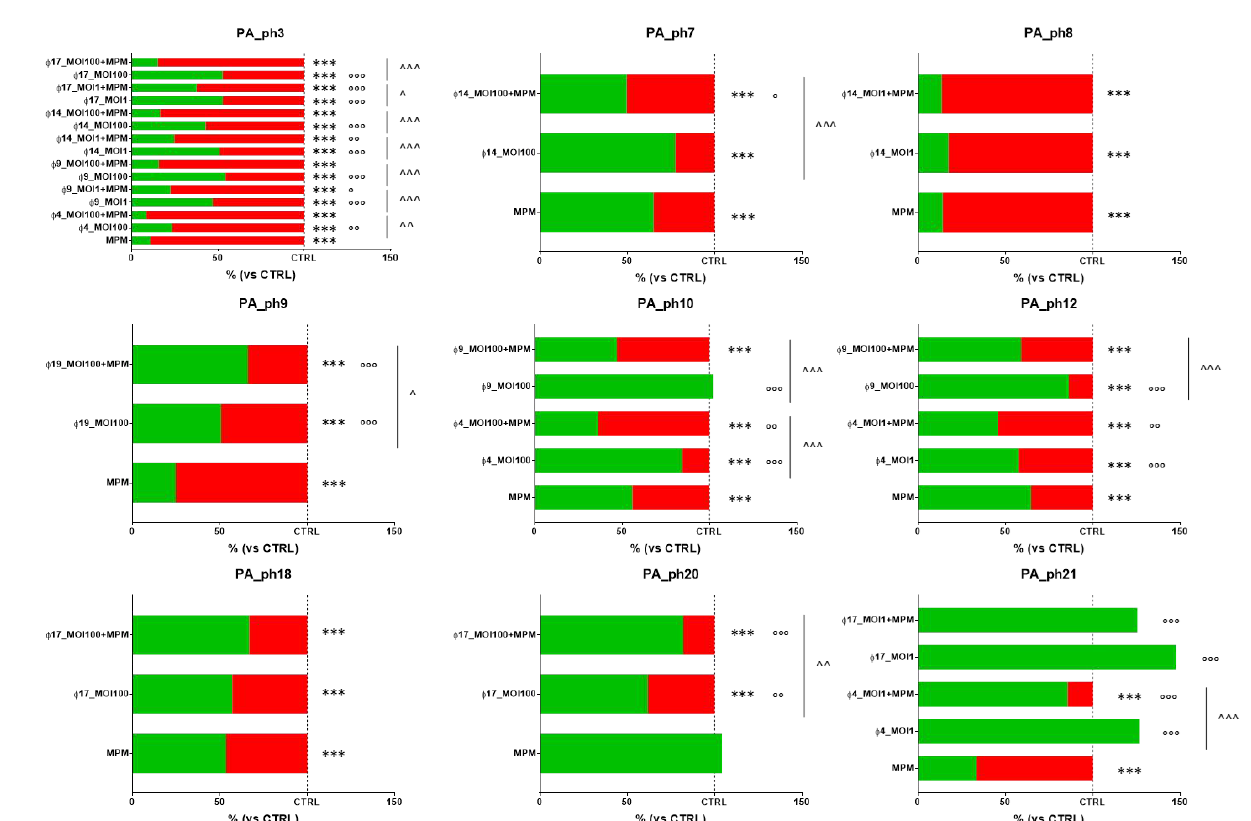
Figure 4. In vitro phage and meropenem (MPM) activity, alone and in combination, against nine 24-h-old cystic fibrosis Pseudomonas aeruginosa (PA) biofilms. Biofilm dispersion evaluated by crystal violet stain. The results are shown as percentages in dispersed PA biofilms (highlighted in red) compared with unexposed PA control samples (CTRL) in trypticase soy broth (TSB); the dotted line indicates 100% residual biofilm after a challenge with TSB; significant levels *** p < 0.001 each treatment vs. CTRL; ◦ p < 0.05, ◦◦ p < 0.01, ◦◦◦ p < 0.001 each treatment vs. MPM, and ˆ p < 0.05, ˆˆ p < 0.01, ˆˆˆ p < 0.001 each treatment vs. phage-MPM analyzed by the χ 2